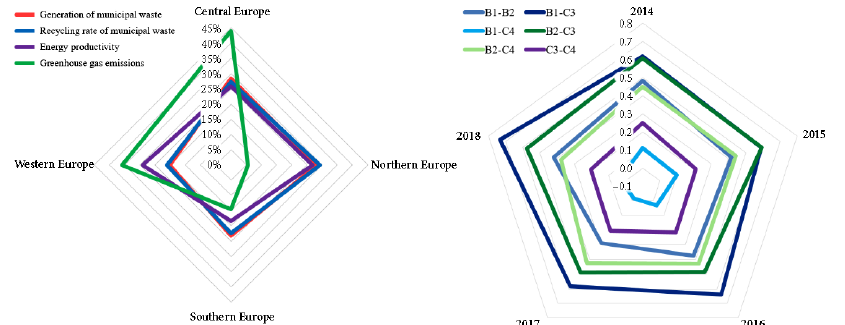
Figure 2. Regional B1, B2, C2, and C4 share from the analysed European area. The evolution of the Pearson correlation coefficient (source: authors’